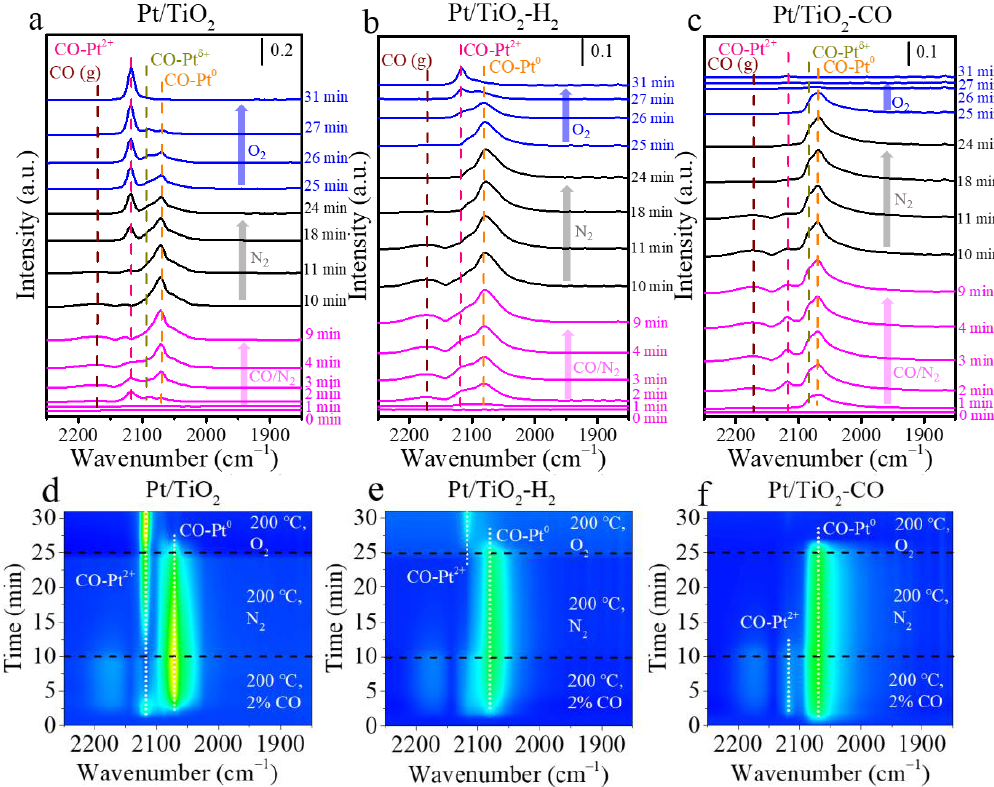
Figure 5. ( a – c ) Adsorbed CO, and ( d – f ) Contour map of in situ DRIFT spectra in the CO adsorption–desorption–oxidation and in situ DRIFT spectra for ( a , d ) Pt/TiO 2 , ( b , e ) Pt/TiO 2 -H 2 , and ( c , f ) Pt/TiO 2 -CO catalysts at 200 °C. (Note: In situ DRIFT study was carried in 2 vol.%CO for 10 min, in N 2 for 15 min, and in O 2 for 6 min.)